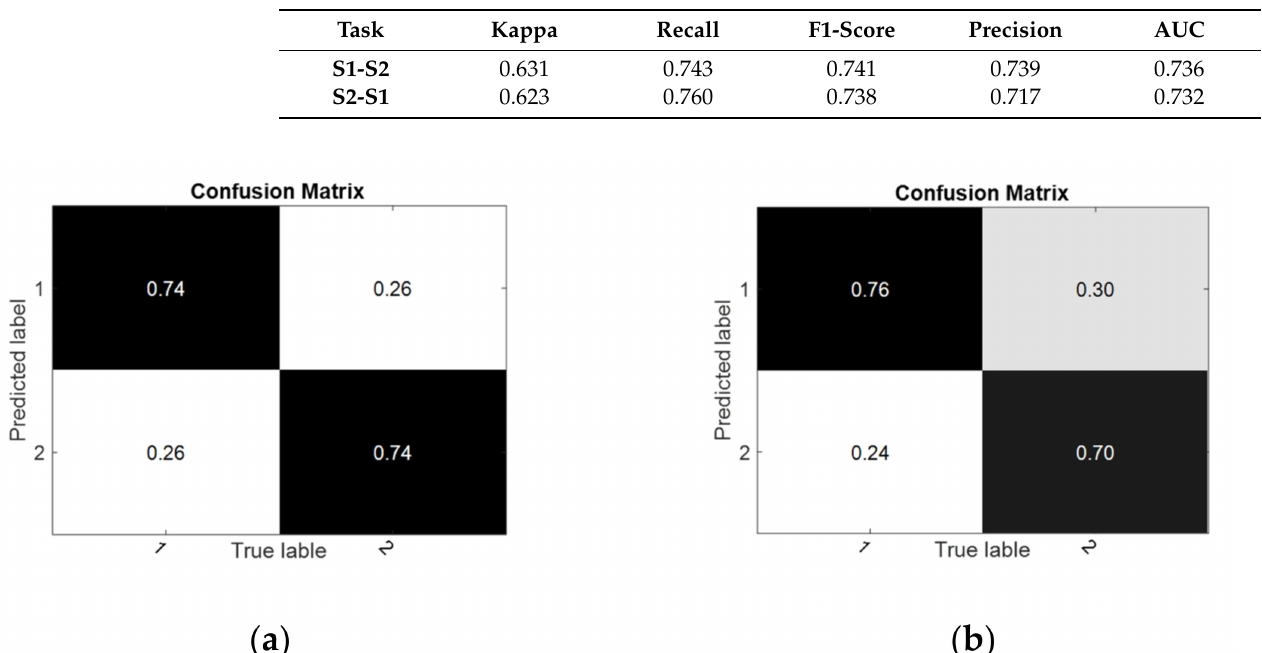
Figure 15. The results of the different classifiers in the cross-session experiment. Table 6. The performance matrices of RF in the cross-session experiments.